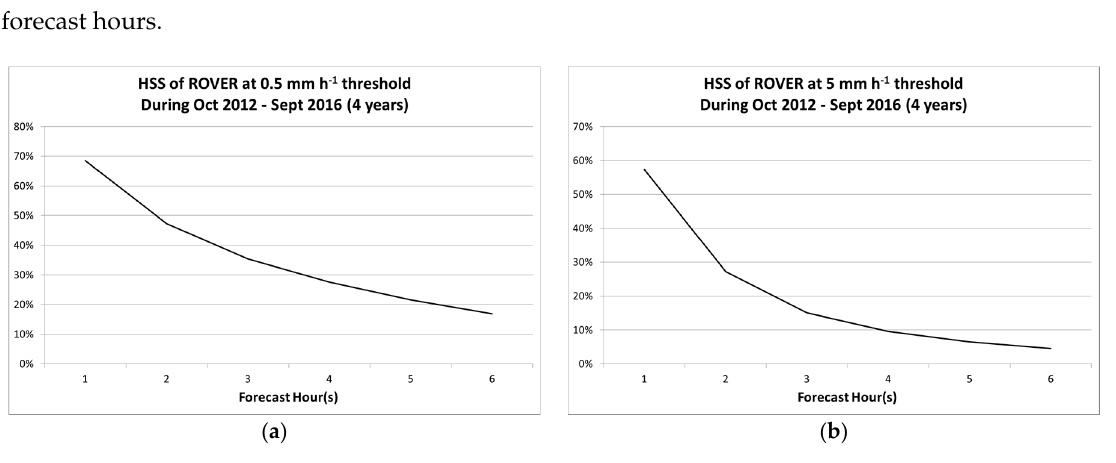
Figure 12. HSS of ROVER at: ( a ) 0.5 mm·h − 1 ; and ( b ) mm·h − 1 thresholds based on four years of data.